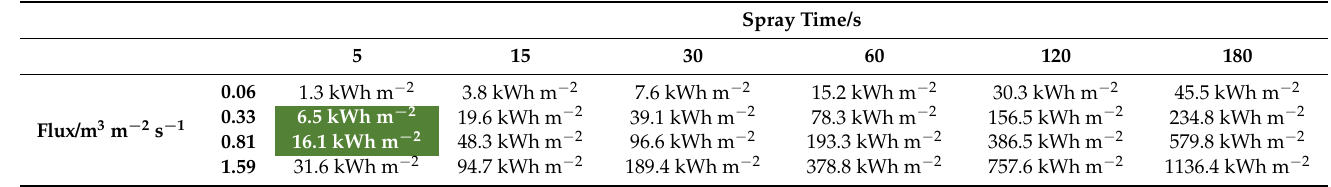
Table 7. Electric energy demand per square meter for all cleaning parameter combinations. High- lighted are the successful combination with the lowest water demand for front- and